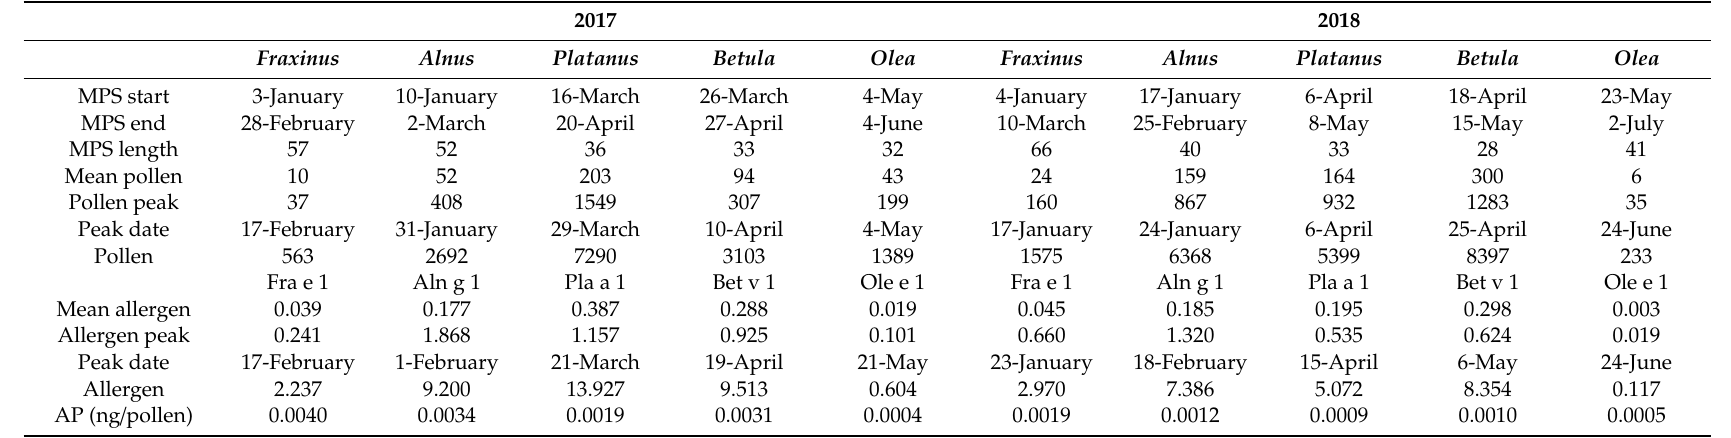
Table 1. Date of the start, end and length of the main pollen season (MPS) (days), mean pollen (pollen / m 3 ), date of the pollen peak (day), pollen (pollen) and allergen, allergen peak of the MPS (ng / m 3 ), date of the allergen peak (day) and Pollen Allergen Potency (AP) (ng /